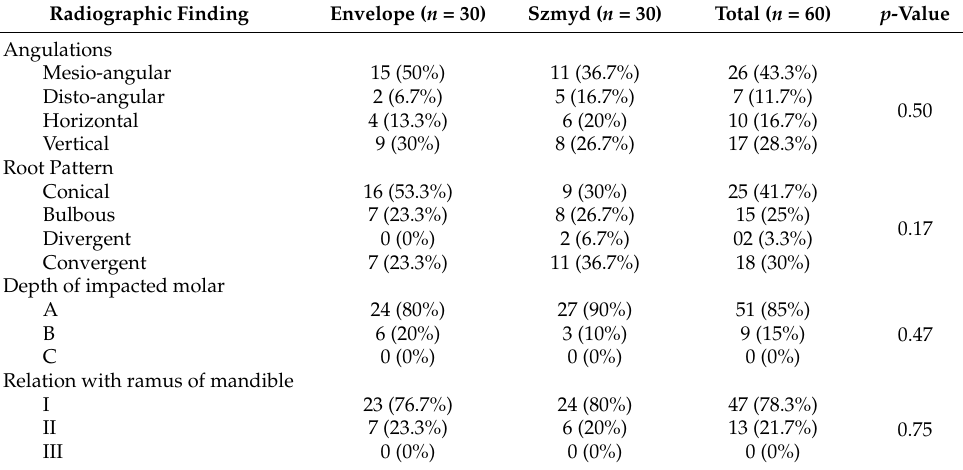
Table 3. Pre-operative impacted third molar radiographic findings among the study